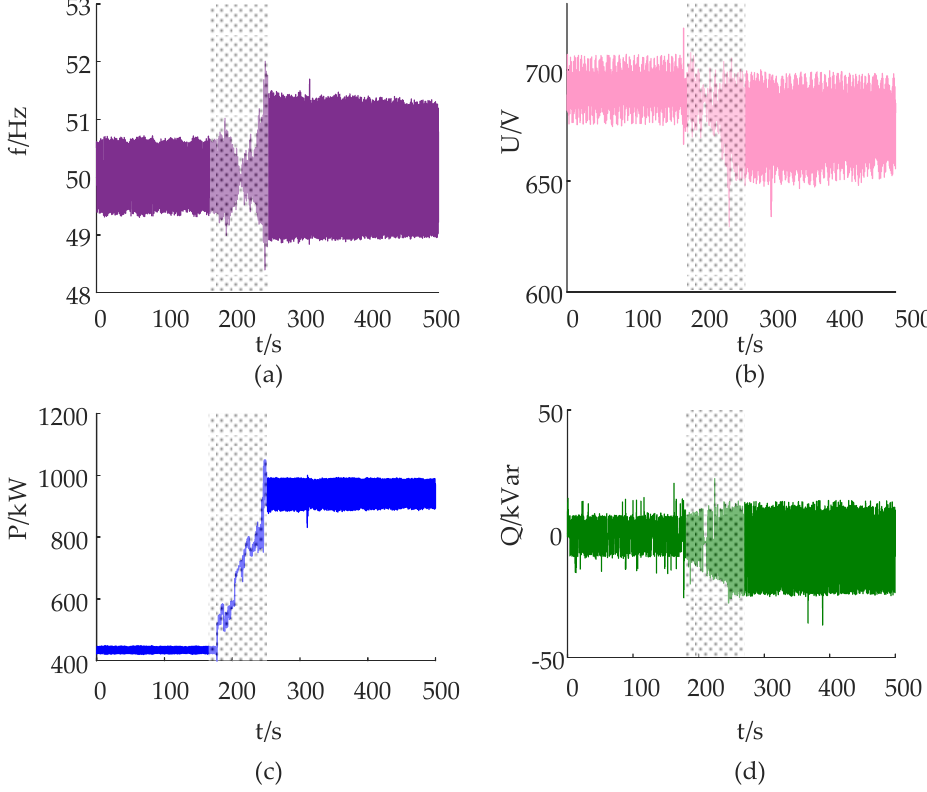
Figure 8. ( a ) system frequency, ( b ) system voltage, ( c ) active power, ( d ) reactive power